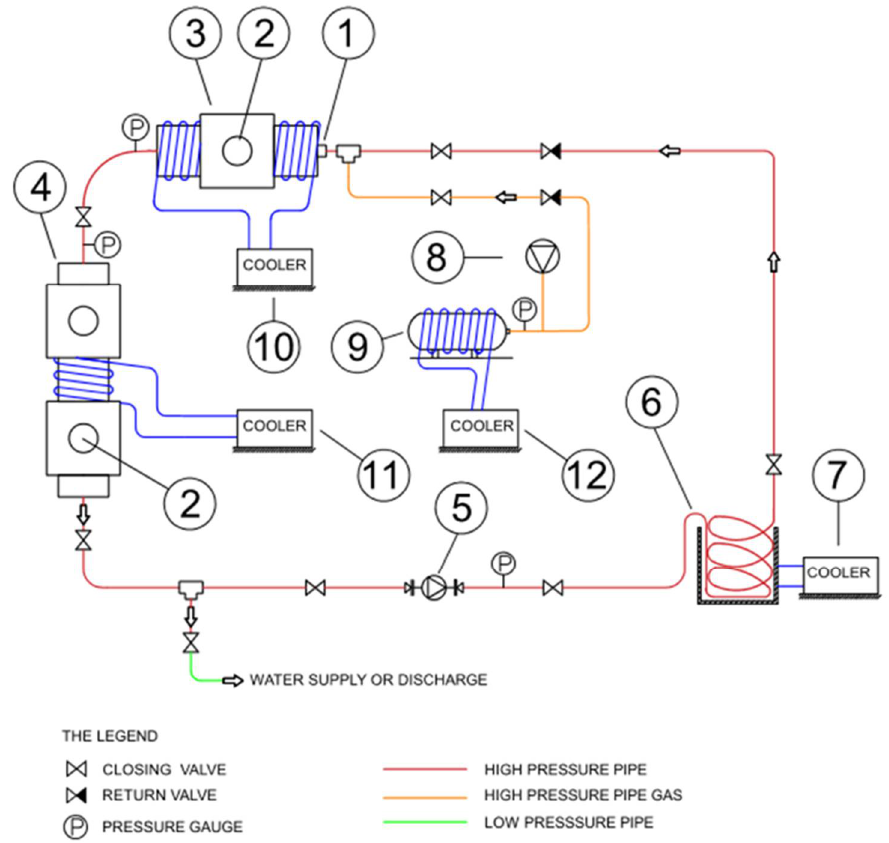
Figure 1. Schematic diagram of the experimental device. The refence lines are described in Table 1. The individual reference lines of the technological devices with numerical designa- tions are specified in more detail in the following Table 1. Table 1. Technological specification of the experimental device.